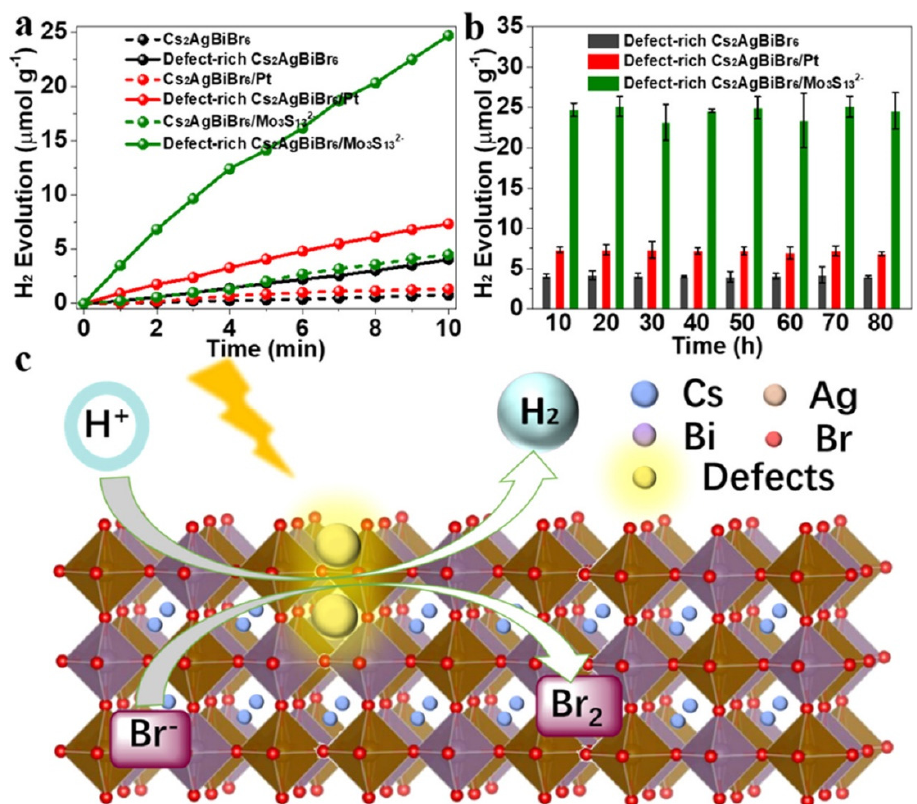
Figure 10. H 2 evolution activity under visible light irradiation ( a ). Photocatalytic stability of the defect-rich Cs 2 AgBiBr 6 , Cs 2 AgBiBr 6 /Pt, Cs 2 AgBiBr 6 /Mo 3 S 132 − ( b ). Schematic illustration of H 2 evolution over the defect-rich Cs 2 AgBiBr 6 ( c ). Reprinted with permission from ref [39]: Copyright 2021, American Chemical Society